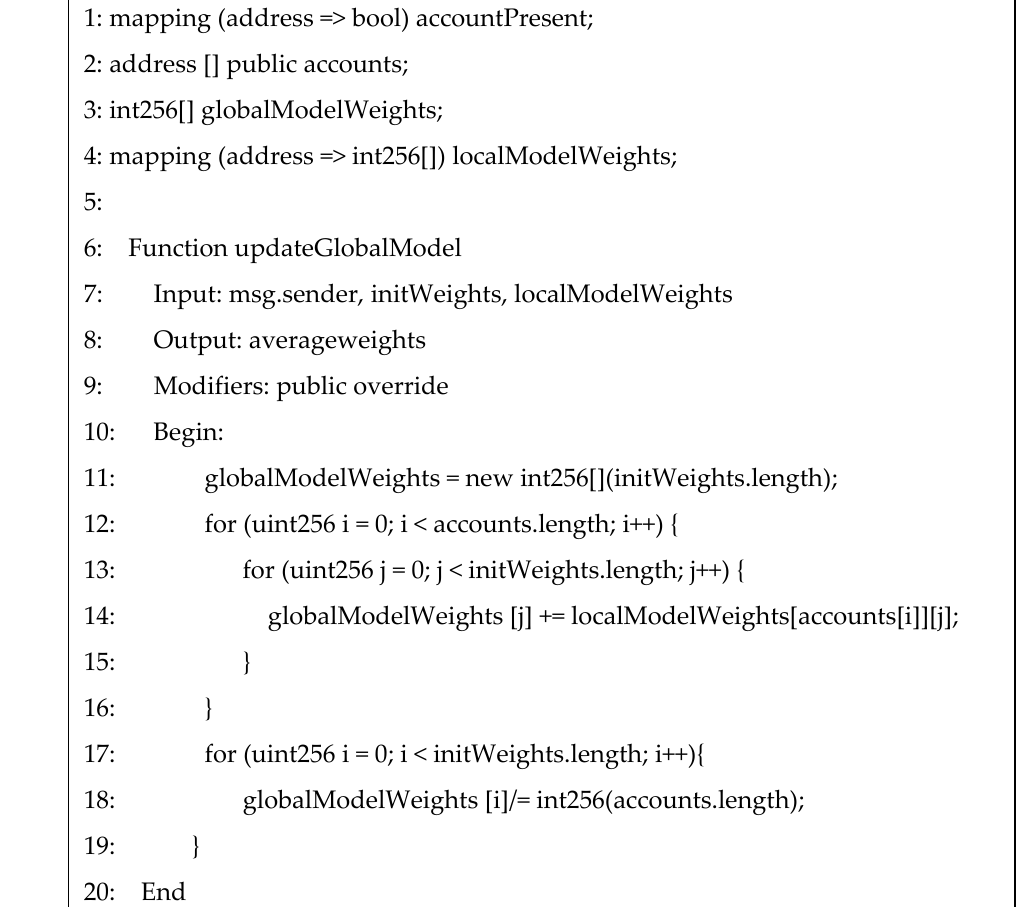
Figure 5. Smart contract function for updating the global energy-demand prediction model weights.